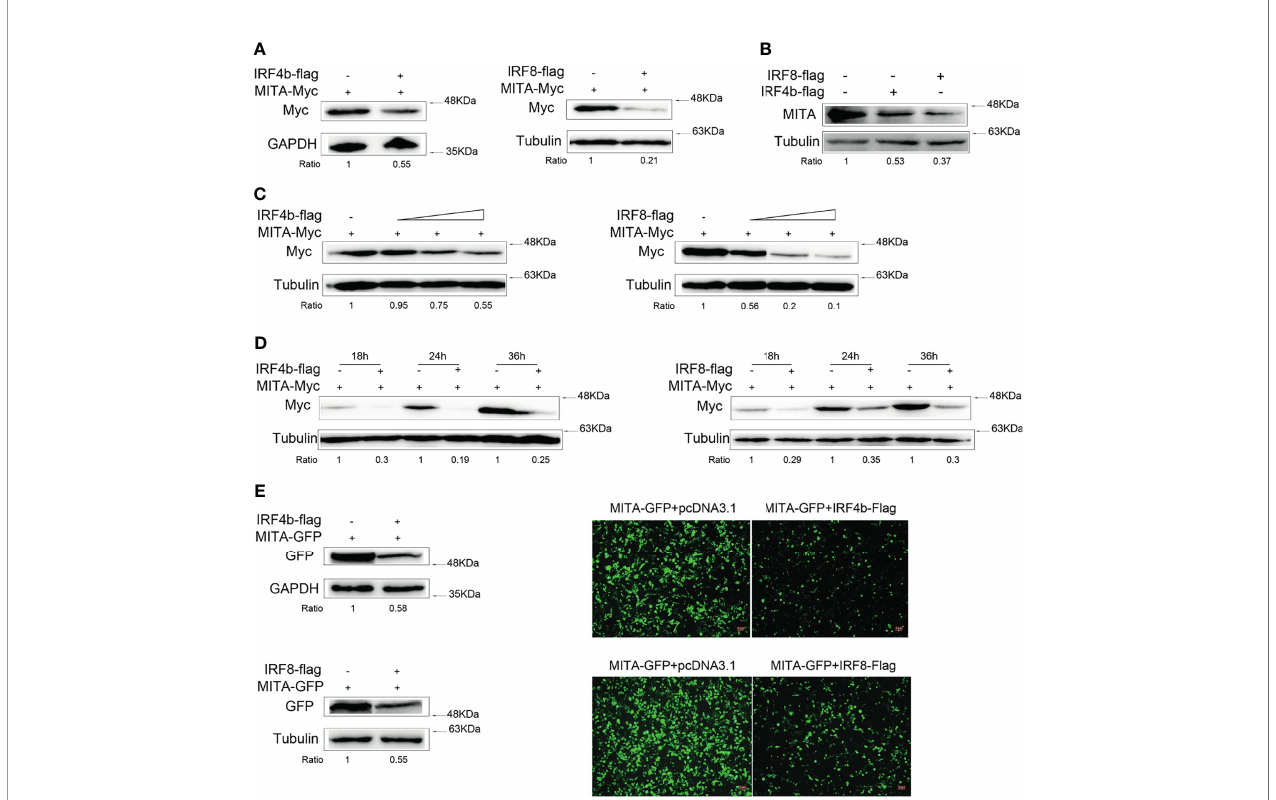
FIGURE 3 | IRF4b and IRF8 promote MITA degradation. (A) EPC cells were seeded onto 12-well plates to transfect with pcDNA3.1, IRF4b-Flag, or IRF8-Flag together MITA-Myc in a 1 m g dose for each plasmid. At 24 h after transfection, the protein level of MITA was examined by immunoblot assays and normalized to GAPDH and tubulin. (B) A total of 0.8 m g of pcDNA3.1, IRF4b-Flag, and IRF8-Flag was transfected into MKC, respectively. The cells were then lysed 24 h later, and the expression of endogenous MITA was checked by immunoblot assays and normalized to tubulin. (C) The concentration experiments of IRF4b and IRF8 were carried out. Together with the increasing doses (0.2, 0.4, or 0.8 m g) of IRF4b or IRF8, 0.8 m g of MITA was transfected into EPC cells, in which the pcDNA3.1 was used to make the balance of the dose, and MITA was examined by immunoblot assays fi nally. (D) EPC cells were transfected with IRF4b or IRF8 together with MITA, and cells were lysed at different time points to check the expression of MITA by immunoblot assays and be normalized to tubulin. (E) HEK293 cells were seeded onto 12-well plates overnight and transfected with MITA-GFP, IRF4b-Flag, or IRF8-Flag. Green signals arising from MITA-GFP was detected by fl uorescence microscopy (right), and the cells were lysed for immunoblot assays (left) the fl uorescence intensity was observed by Leica DMiL8 fl uorescence microscope. Scale bar, 20 mm; original magni fi cation ×10. All the experiments were performed independently at least for three